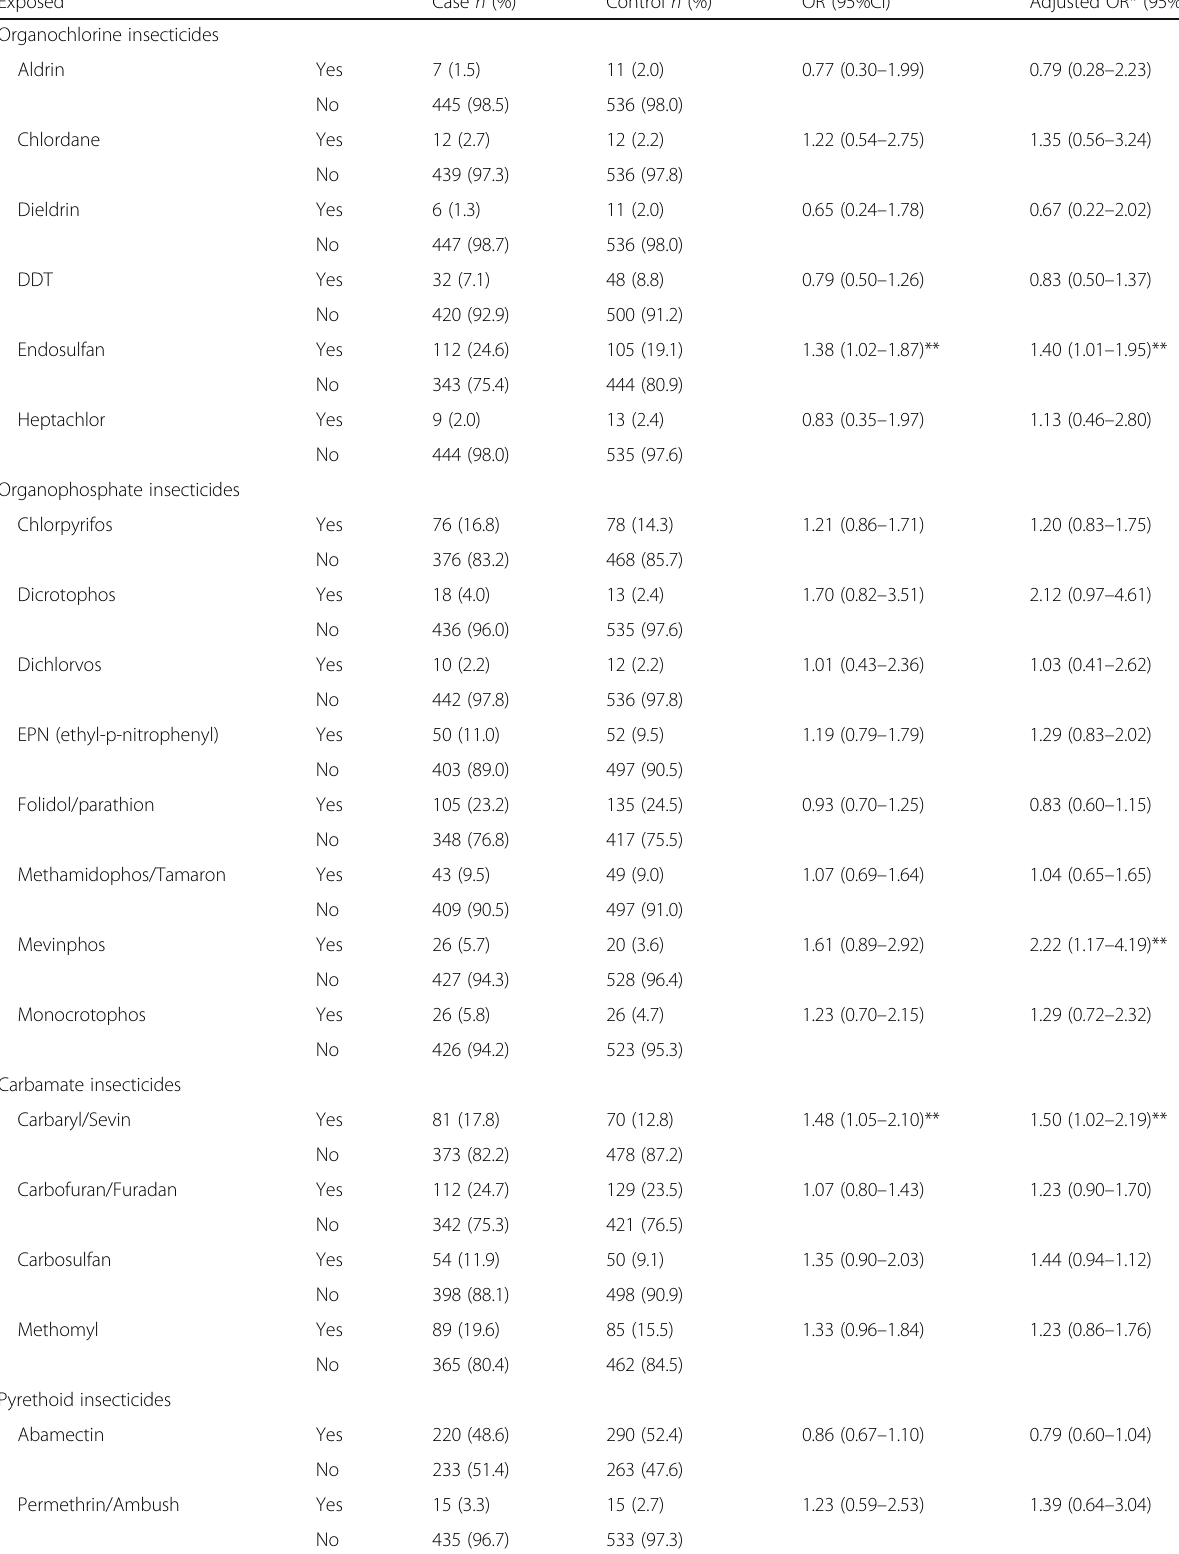
Table 3 Associations between individual pesticide and diabetes